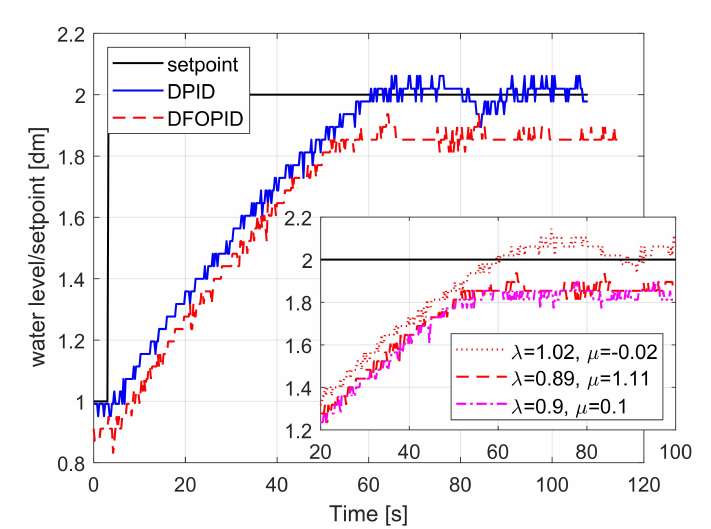
Figure 15. Control systems responses for the DPID and DFOPID controllers; sampling time equals 0.15 s.